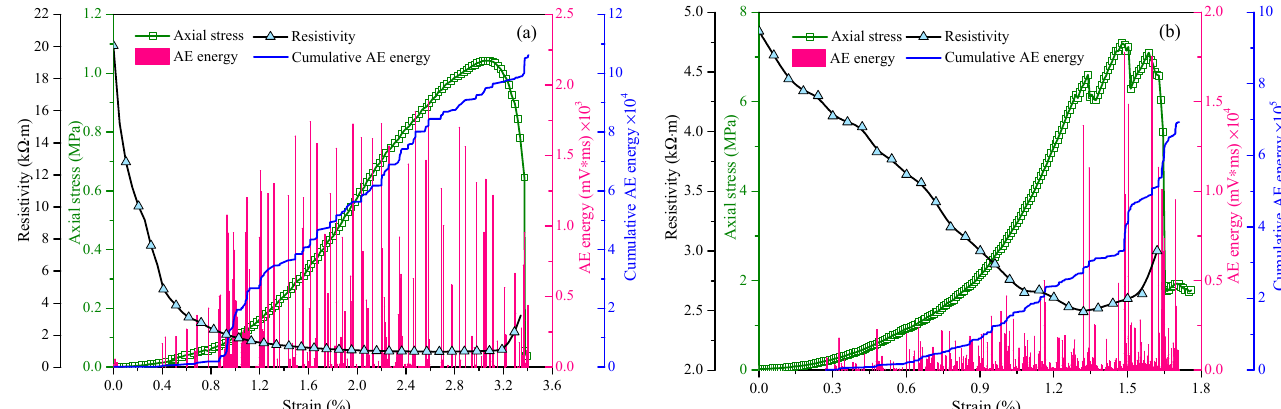
Figure 15. Relationship between stress and AE energy of coal samples under uniaxial compressive loading. ( a ) RTC; ( b ) Intact coal.